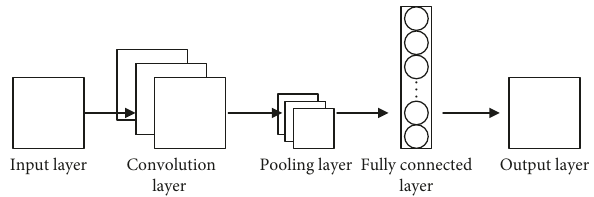
Figure 2: Convolutional neural network structure, with input layer, convolution layer, pooling layer, fully connected layer, and output